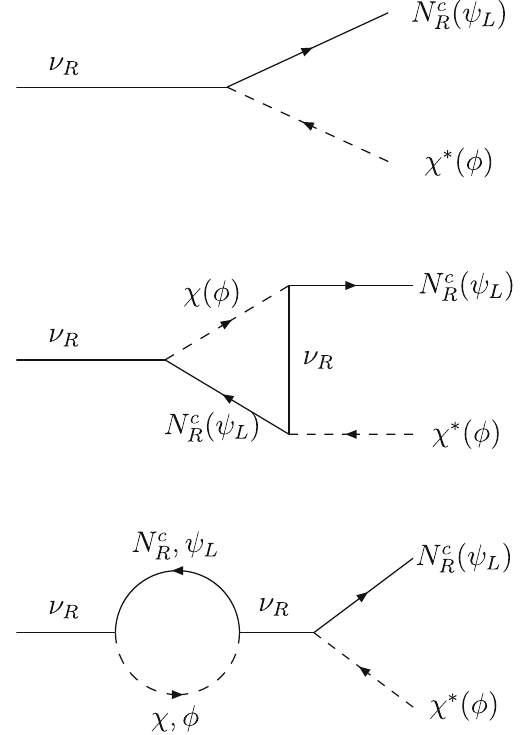
Fig. 1 CP-violating decays of ν R that produce both dark matter N χ and normal matter (ψφ) ,